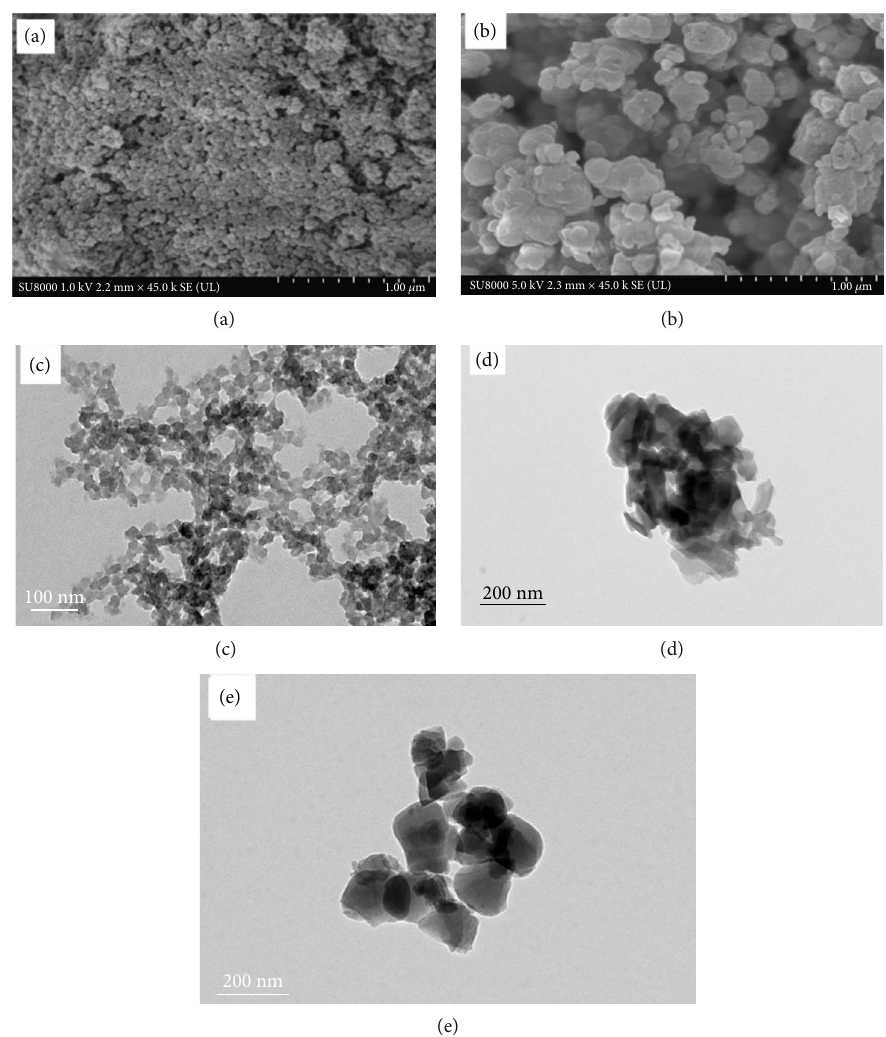
Figure 2: SEM and TEM characterization (SEM: (a) UiO-66 (acetic acid); (b) UiO-66 (hydrochloric acid); TEM: (c) UiO-66 (acetic acid); (d) UiO-66 (acetic acid); (e) UiO-66 (hydrochloric